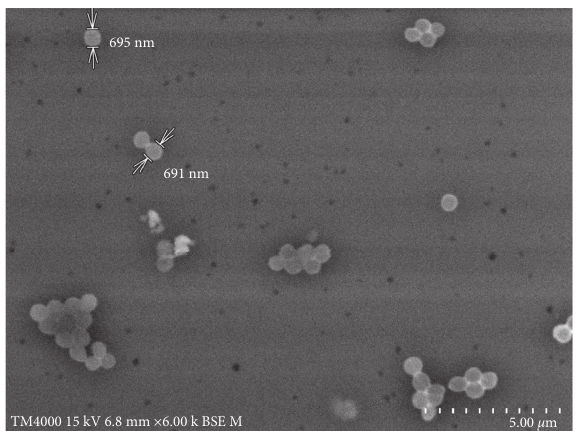
Figure 4: Scanning electron microscopy of B . epidermidis sp. nov. strain Marseille-Q2903 T using a TM4000 microscope (Hitachi High-Tech, HHT, Tokyo, Japan). Table 1: Differential phenotypic characteristics of Brachybacterium epidermidis strain Marseille-Q2903 T and closely related bacterial